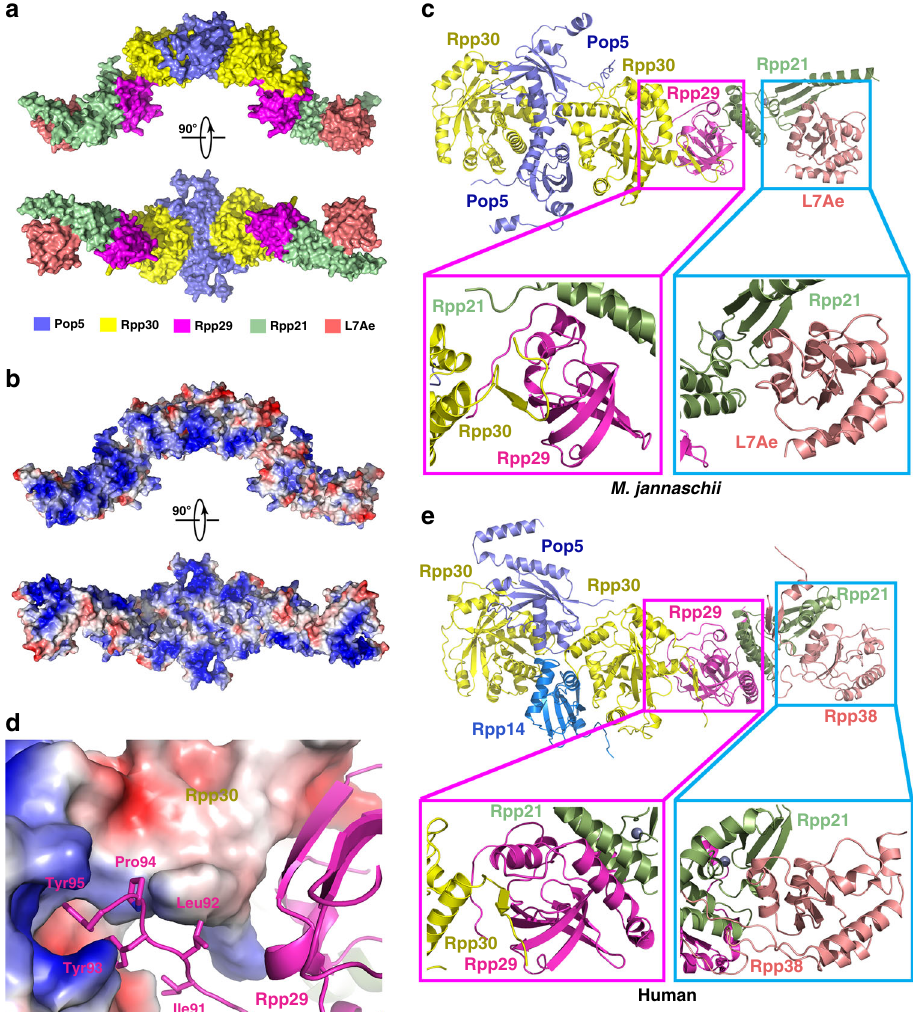
Fig. 4 Protein components of Mja RNase P. a Two orthogonal views of the Mja RNase P protein assembly is shown in surface representation. Protein components are color-coded and the scheme is shown below the fi gure. b Two orthogonal views of the electrostatic surface potential of the protein assembly (negative: red; positive: blue). c Cartoon representation of the Mja (Pop5-Rpp30) 2 -Rpp29-Rpp21-L7Ae heptamer. Protein components are colored as in ( a ). Bottom left: close-up view of the interface between Rpp30 and Rpp29. Bottom right: close-up view of the interface between Rpp21 and L7Ae. d The C-terminal tail of Rpp29 binds into a hydrophobic groove of Rpp30. Rpp30 is shown in electrostatic surface representation and Rpp29 is shown in cartoon. e Cartoon representation of the human Pop5-Rpp14-(Rpp30) 2 -Rpp29-Rpp21-Rpp38 heptamer. Bottom left: close-up view of the interface between Rpp30 and Rpp29. Bottom right: close-up view of the interface between Rpp21 and